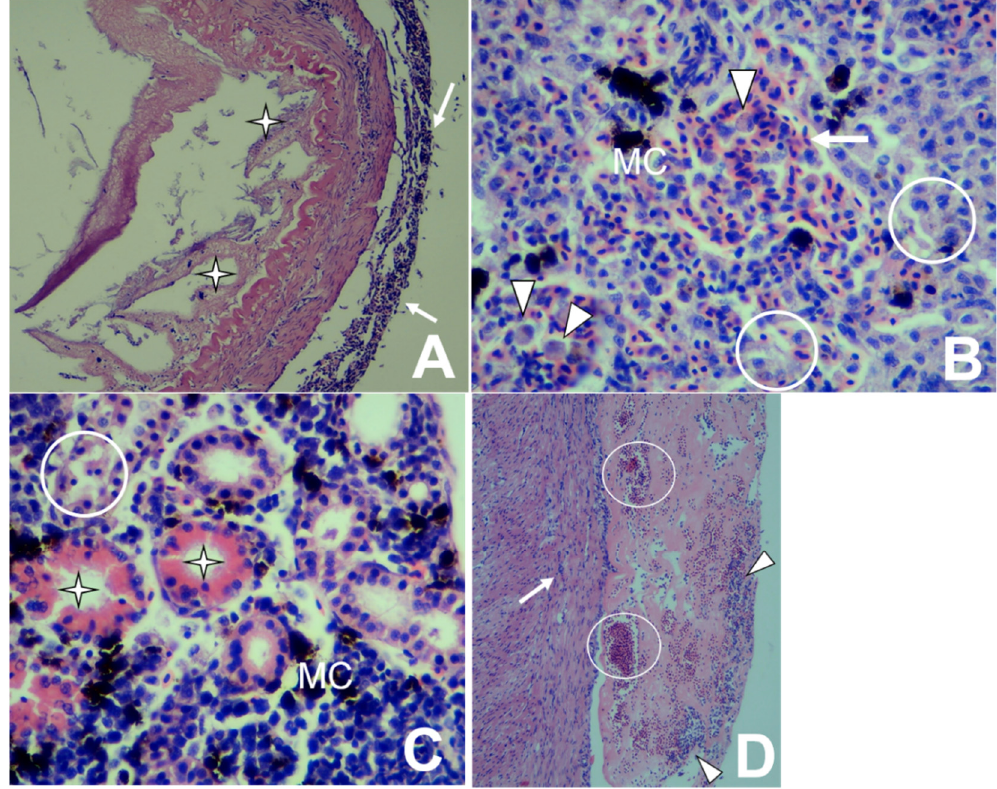
Figure 2. Histopathological changes in rainbow trout infected with Lactococcus garvieae . ( A ) Intestine: Mononuclear peritonitis (arrows) with a loss of intestinal mucosa and villi (stars) [H&E stain 100 × ]. ( B ) Liver: Mononuclear hepatitis with congestion (arrow), degeneration and necrosis (circles), macrophage proliferation (arrowheads), and melano-macrophage centers (MC) [H&E stain 400 × ]. ( C ) Kidney: Degeneration and tubular necrosis (circle) with the presence of proteinaceous material within tubules (star) and the proliferation of melano-macrophage centers (MC) [H&E stain 400 × ]. ( D ) Heart: Mononuclear epicarditis (arrow) and pericarditis (arrowheads), as well as congestion (circles) [H&E stain 100 × ].